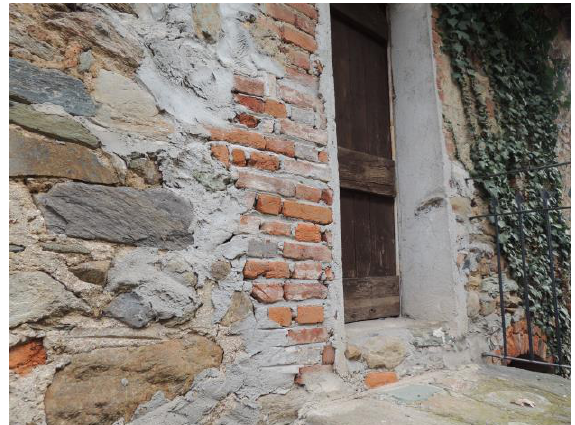
Figure 12. Building G - Improper intervention with cement mortar (credits Fabio